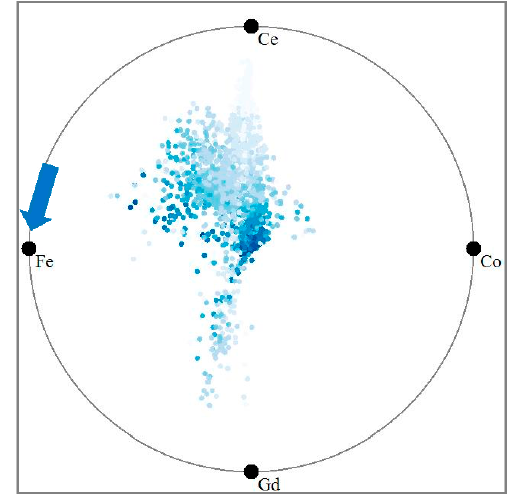
Figure 9. Mapping sample value to intensity for RadViz.